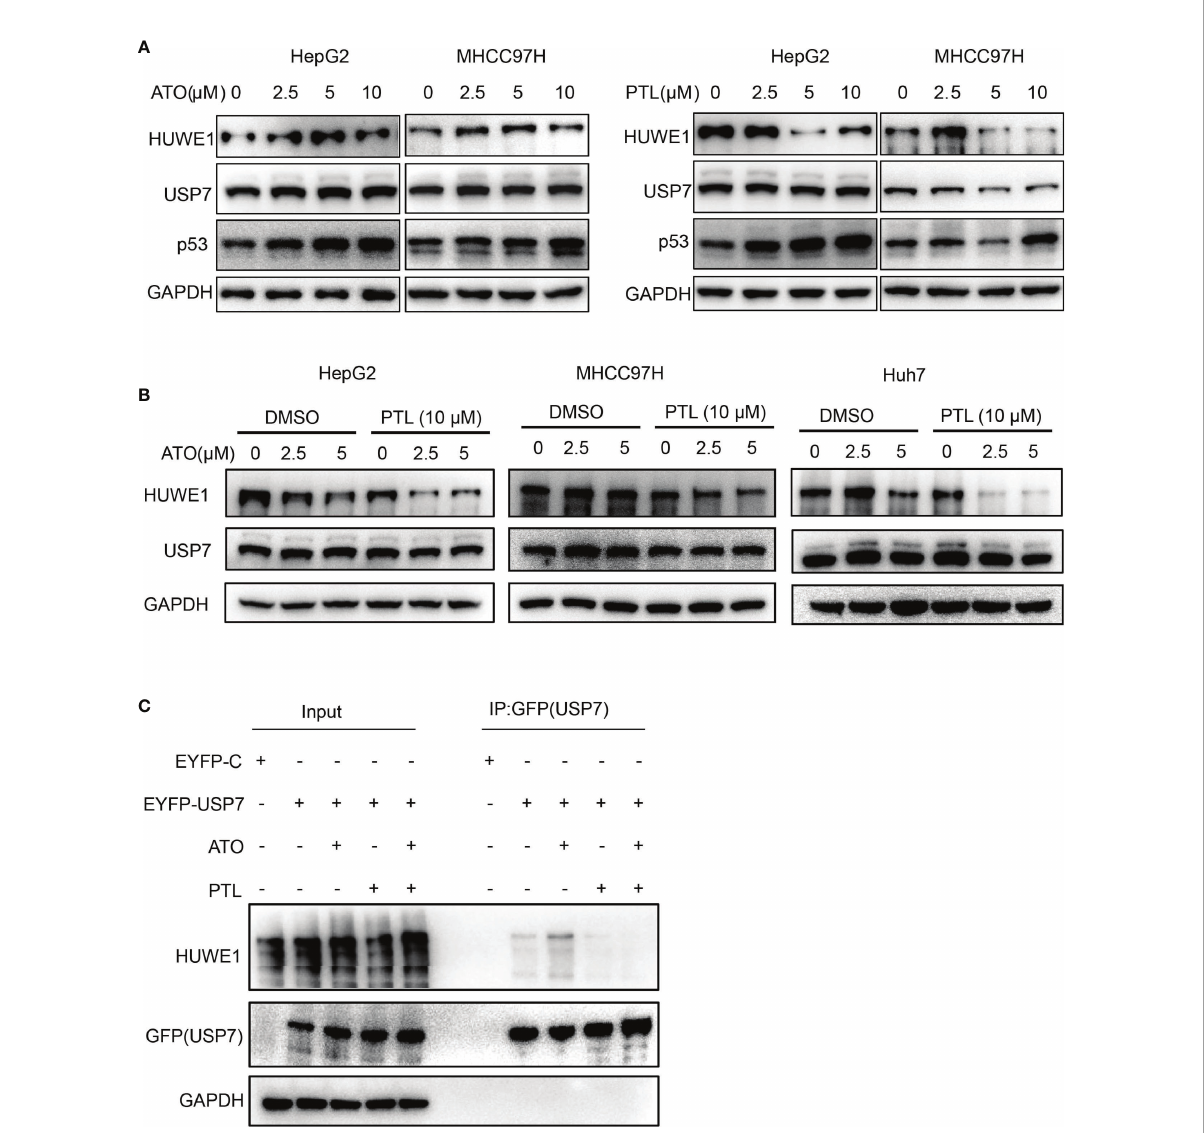
FIGURE 5 USP7-HUWE1 is related to PTL enhancing ATO-induced apoptosis of HCC cell lines. (A) HepG2 cells and MHCC 97H cells were treated with indicated concentrations of ATO or PTL for 24 h. The cells were collected and subjected to western blotting. (B) HepG2 cells, MHCC97H cells and Huh7 cells were treated with ATO, PTL and ATO plus PTL for 24 h, followed by analysis with western blotting. (C) Designated plasmids were transfected into HepG2 cells for 24 h, and then cells were treated with indicated concentrations of ATO or TL for 24 h. Harvested cells were lysed with IP lysis buffer and subjected to IP using GFP-agrose and western blotting analysis with the indicated